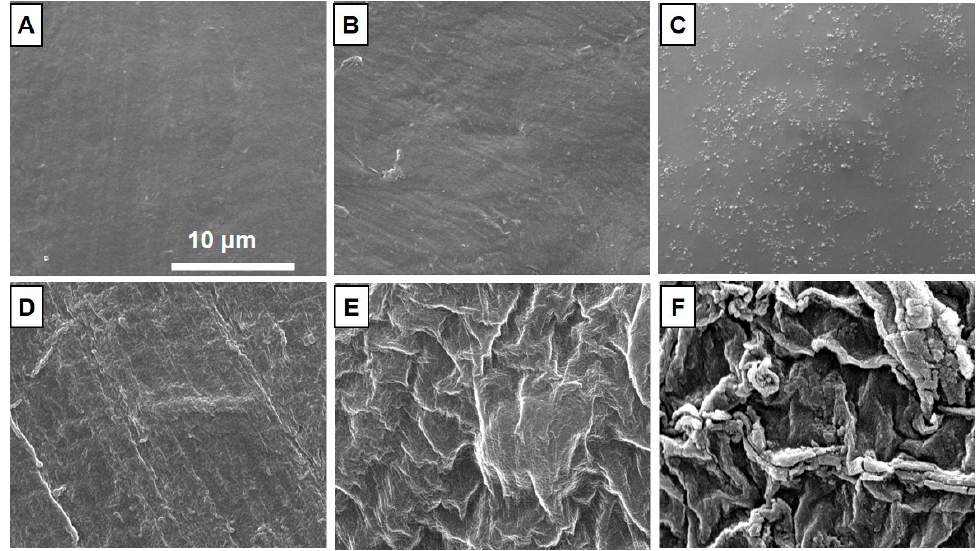
Figure 4. SEM images of fractured surfaces of MCPA6 (100 wt. %)/TLCP-PA6 (x wt. %) containing different contents of TLCP-PA6, i.e., x wt. % = 0% ( A ), 2.5 wt. % ( B ), 10 wt. % ( C ), 15 wt. % ( D ), 20 wt. % ( E ), and 30 wt. % ( F ).